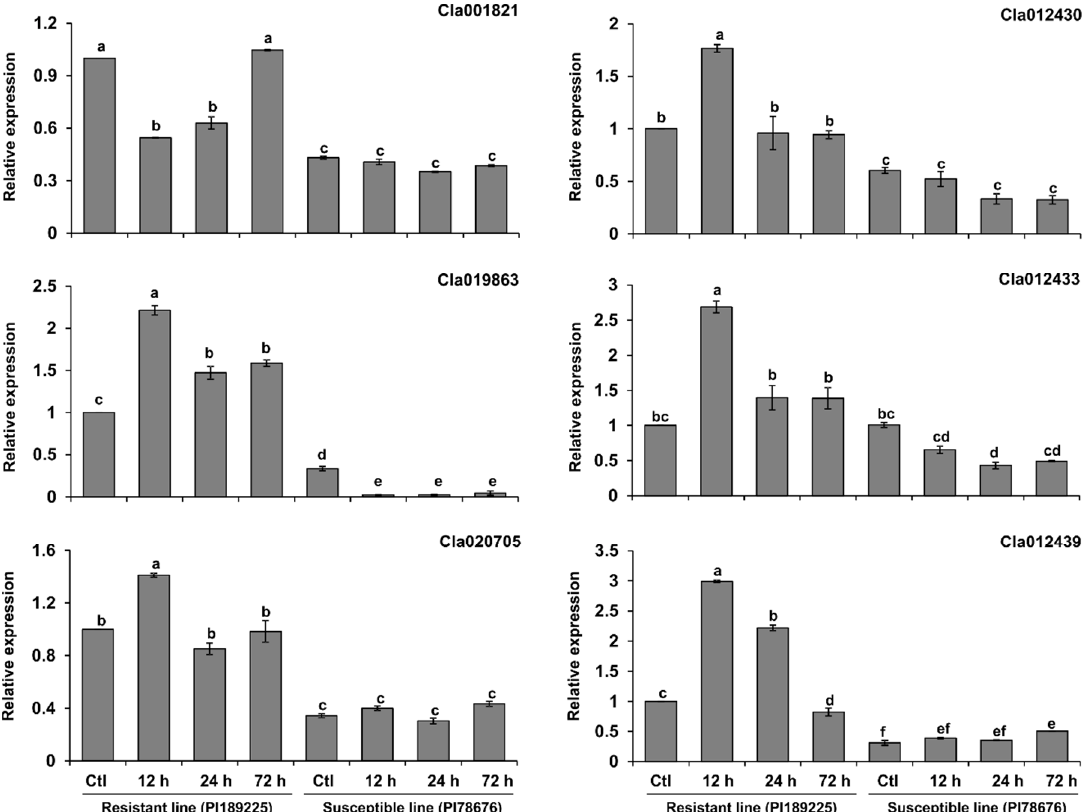
Figure 7. Relative expression levels of candidate NBS-encoding R genes in Didymella bryoniae -resistant and susceptible watermelon lines. Error bars represent ± SE of the means of three technical replicates. Different letters above the bars indicate significant differences.